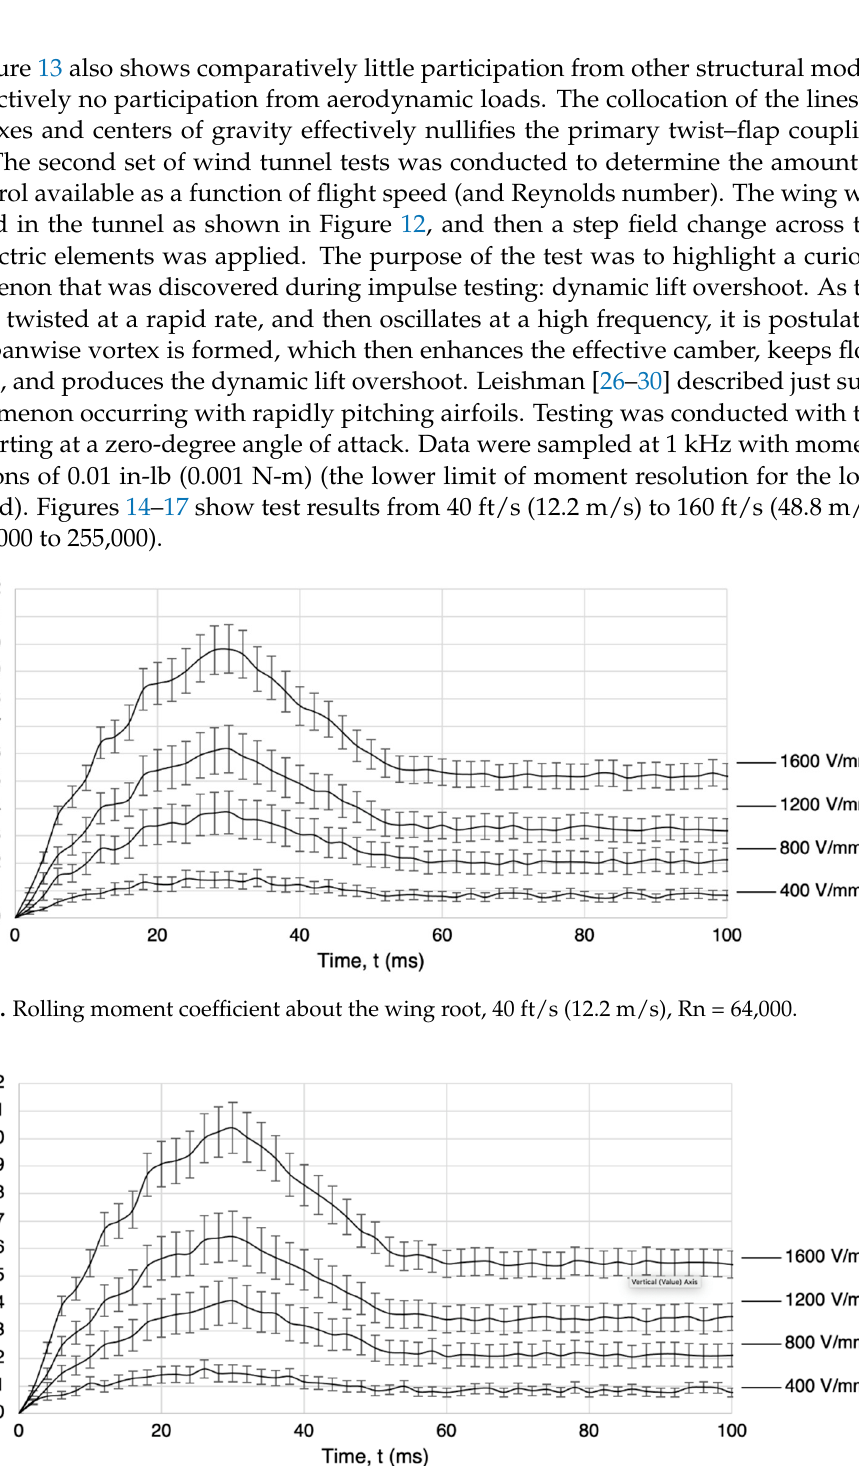
Figure 15. Rolling moment coefficient about the wing root, 80 ft/s (24.4/s), Rn = 127,000.